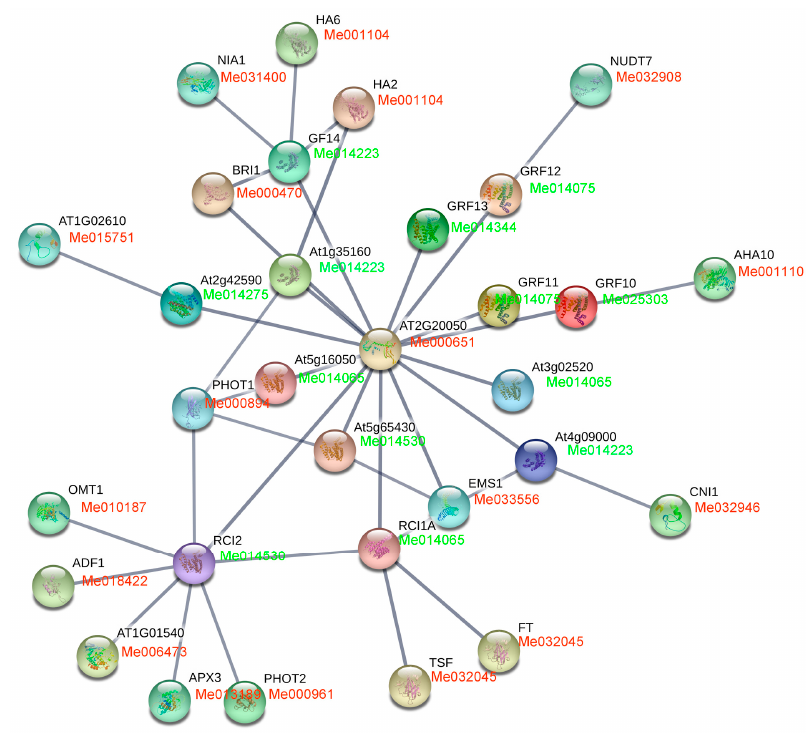
Figure 10. Interaction network analyses of GRFs in Arabidopsis and cassava. The upper one in the nodes represent genes in Arabidopsis . The lower one in the nodes represent genes in cassava. The genes marked with green font show GRFs; the genes marked with red font show the interactors of GRFs.